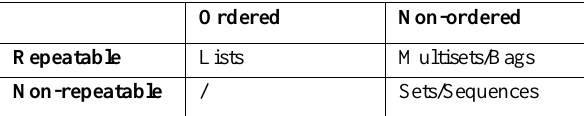
Table 1. Classification of collections